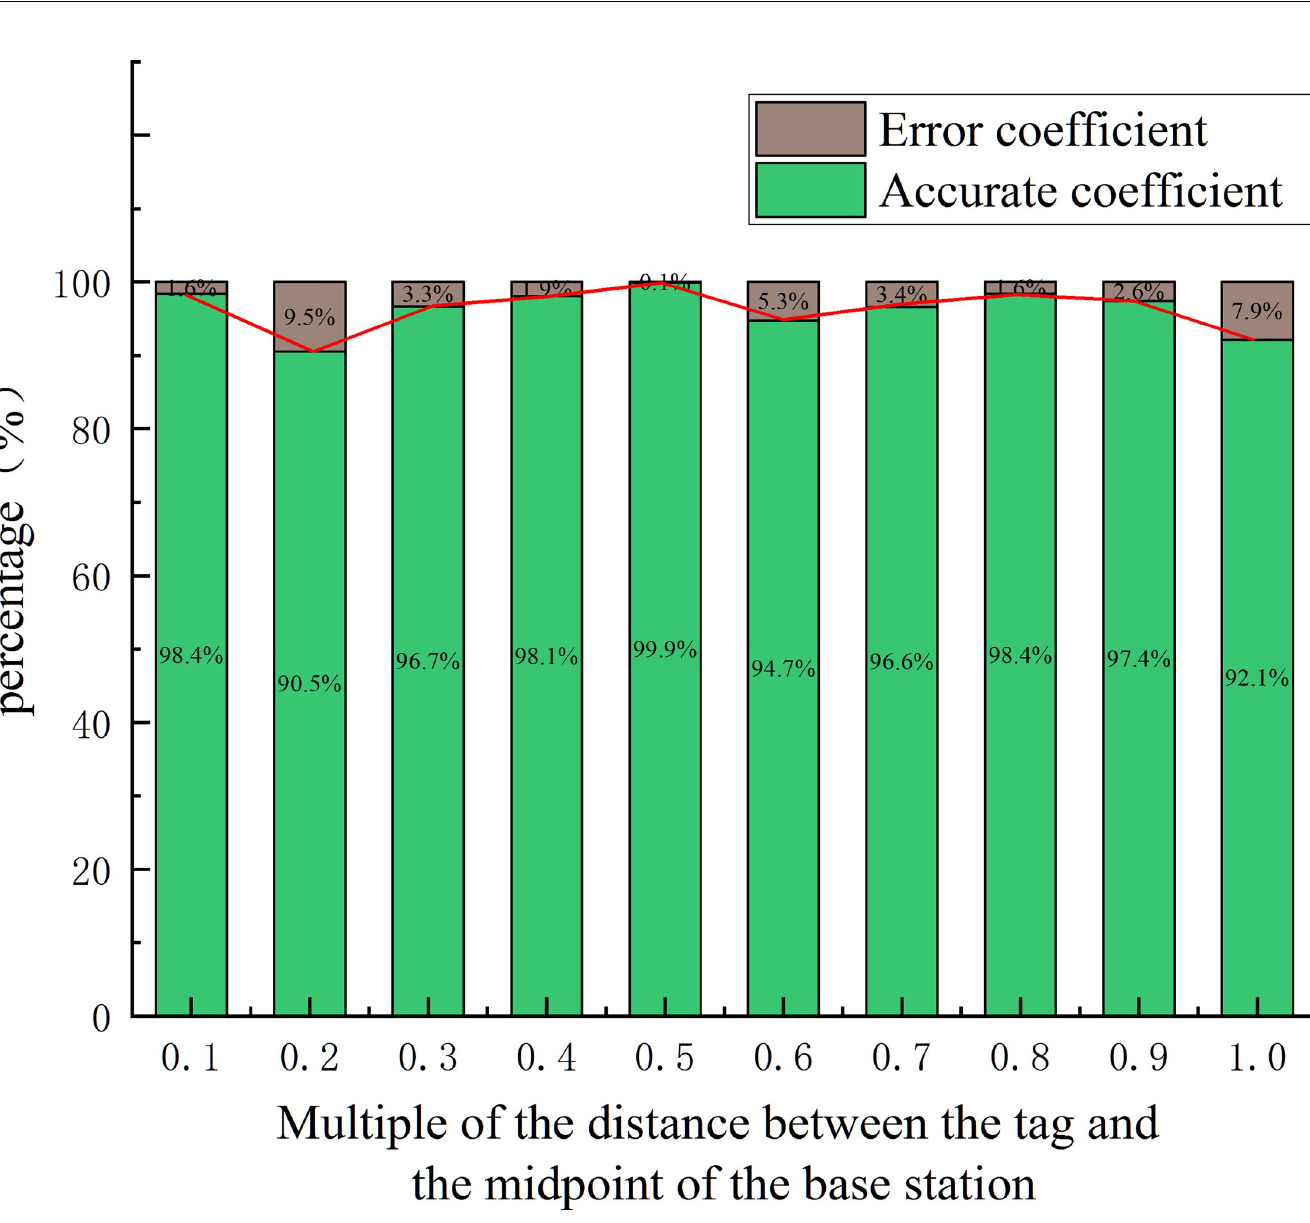
between the base stations is measured. The average of delays for three labels is taken as the delay of the positioning label. To simplify the model of the positioning label delay test, this experiment takes the time that the label reaches the base station as the test time, and the tester moves forward between the positioning base stations at a normal walking speed. It is ensured that the position of the positioning label is stable before starting the test. As the tester begins walking, the tester and background observer simultaneously record the time. When the tester arrives at the horizontal line of the base station, the tester records the actual time of arrival. At this time, the label seen by the delayed background observation has not passed the horizontal line of the base station. A diagram of the experiment is shown in Fig 14. The average time